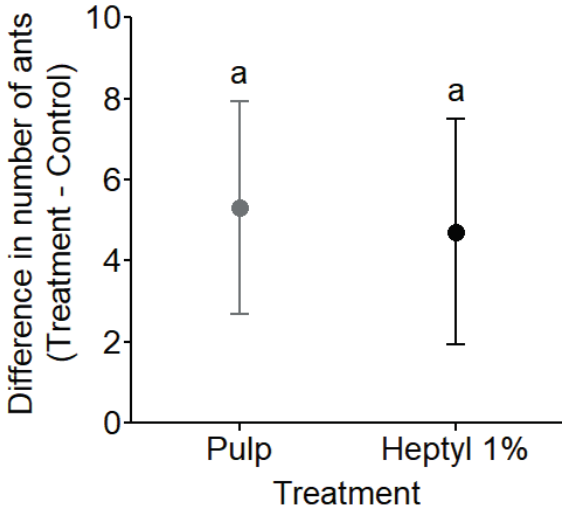
Figure 2 - Difference in number of ants (mean ± SE) in treatment and control filter papers. Treatment filter papers were treated with orange pulp or heptyl butyrate 1%. Similar letters indicate non-significant differences (p = 0.88, N pulp = 10 and N heptyl = 7).